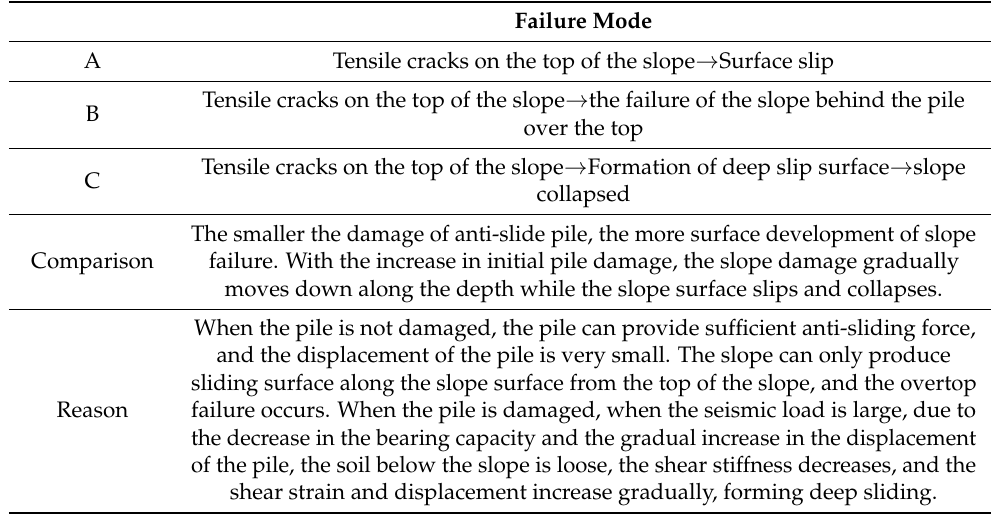
Table 6. Failure mode.